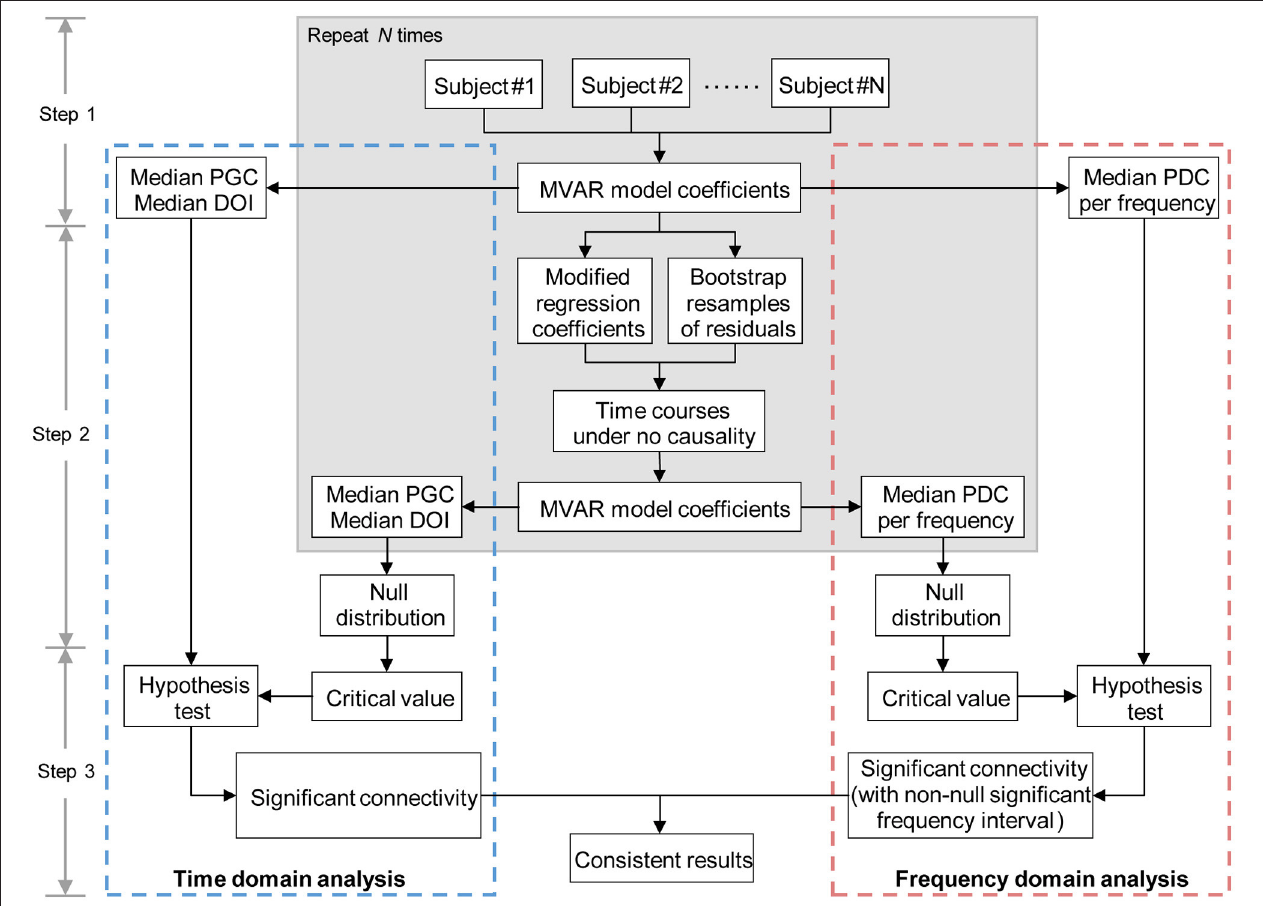
FIGURE 1 | Diagram representing the main steps of combination method of time and frequency domains multivariate Granger causality analyses. MVAR, multivariate regressive; PGC, partial Granger causality; DOI, difference of influence; PDC, partial directed coherence.